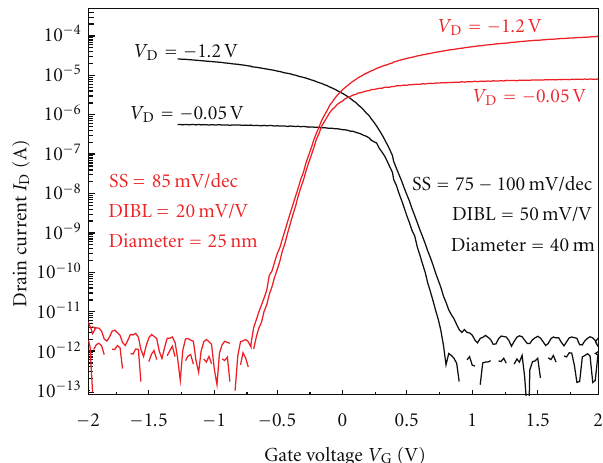
Figure 4: Transfer characteristics of GAA n- and p-FETs showing near ideal subthreshold swing indicating the excellent electrostatic control.